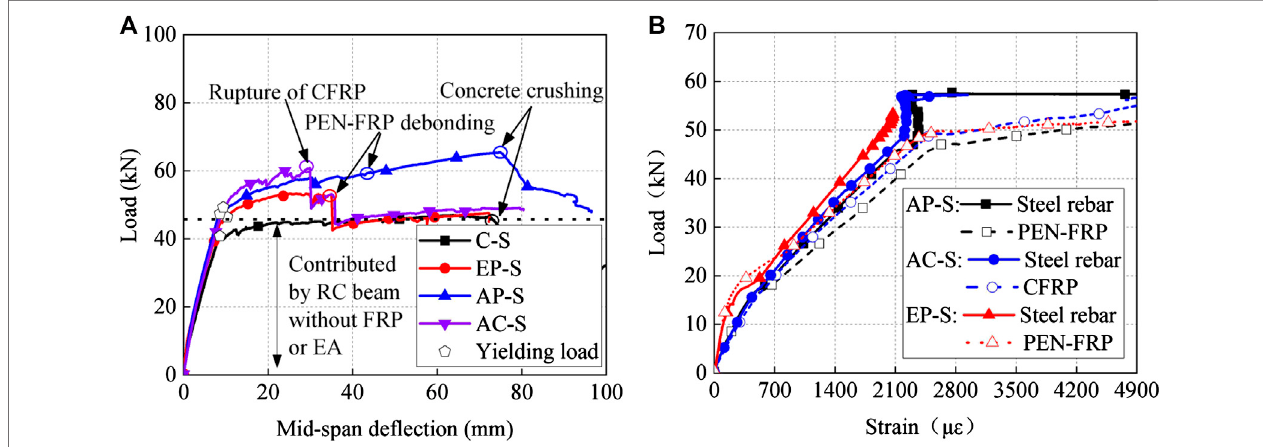
FIGURE 9 | Static performance of specimens. (A) Load – de fl ection relationship, (B) load – strain